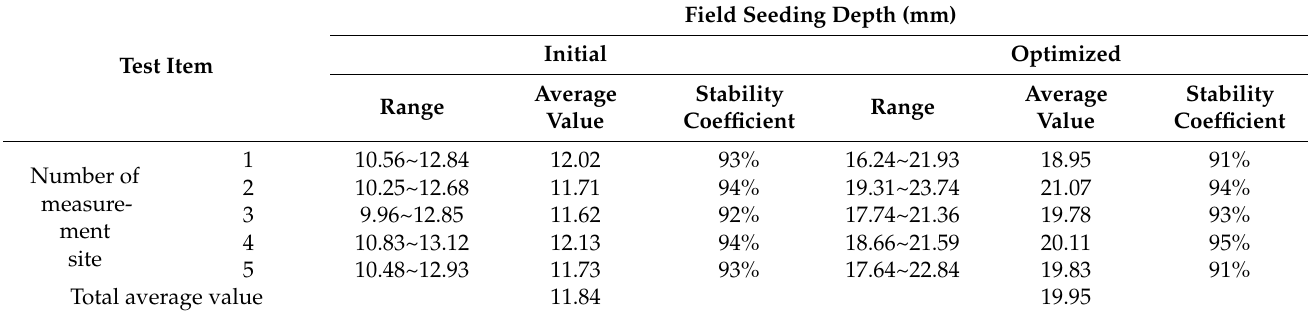
Table 5. Field seeding depth for initial and optimized pneumatic wheat-shooting device.